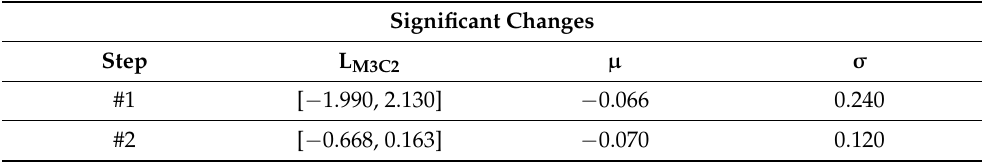
Table 6. Results from the change detection analysis.